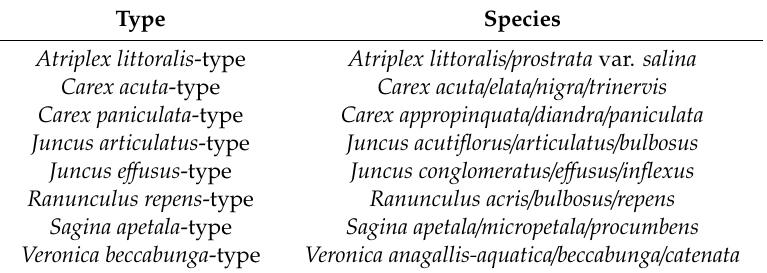
Table 2. Species included in types as based on fruit and seed